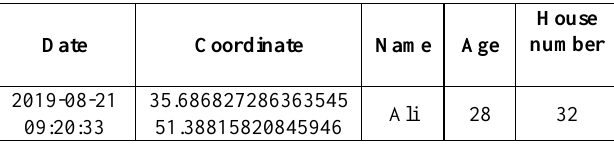
Table 2. The data sent is stored in the database .